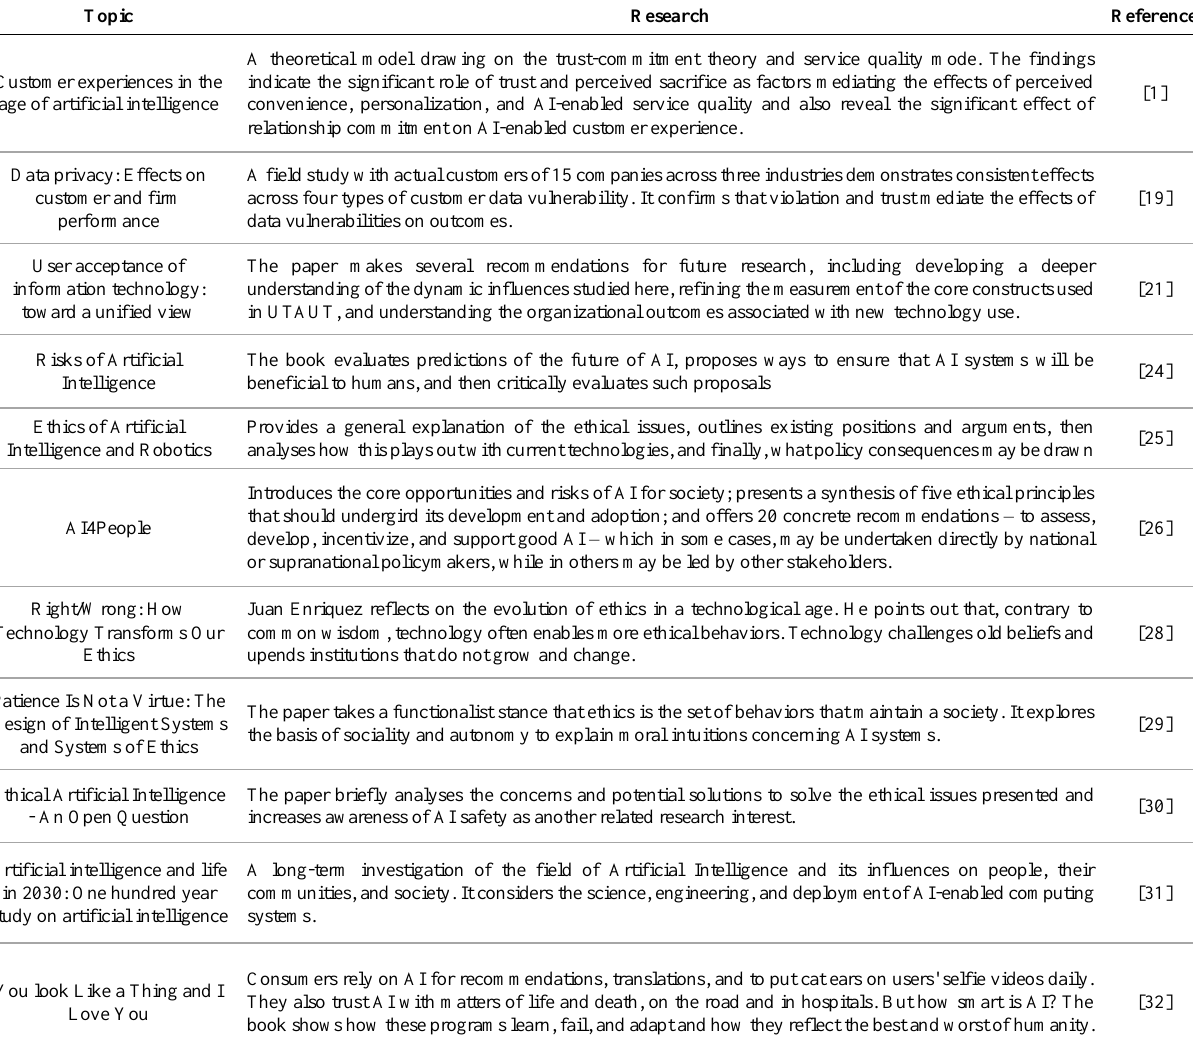
Table 1. Theoretical background on Artificial